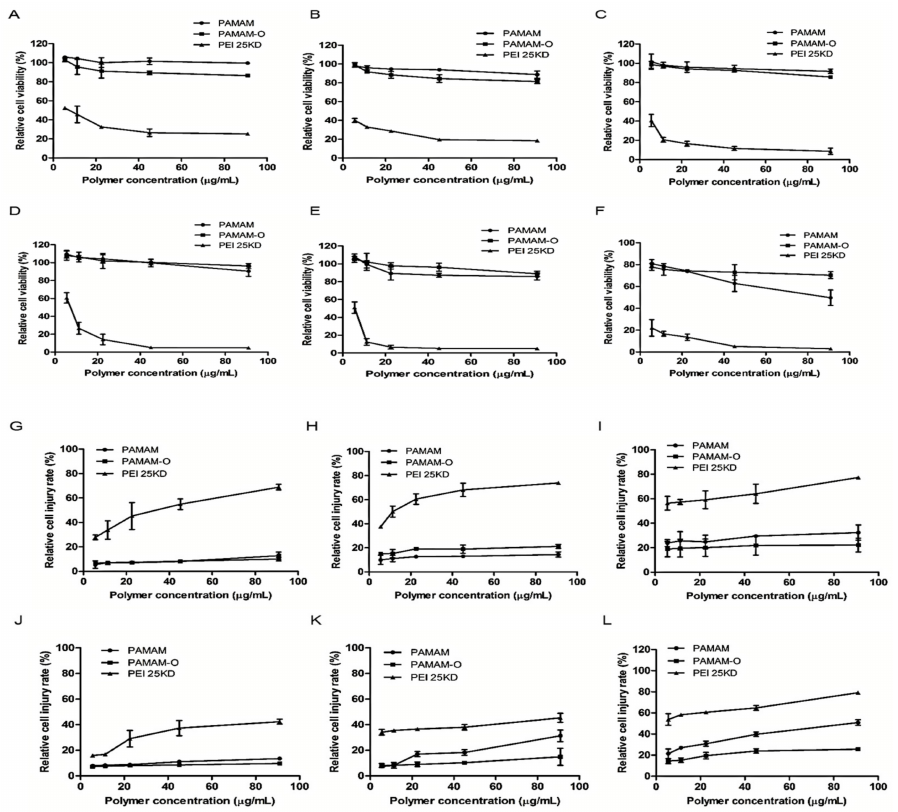
Figure 3. Cell viability assay for the PAMAM and PAMAM-O dendrimers. HepG2 cells were treated with different doses of PAMAM and PAMAM-O dendrimers. After 24 h ( A ); 48 h ( B ); and 72 h ( C ), cell viability was measured by the EZ-Cyto Reagent. Dermal fibroblasts were treated as in panels A, B, and C. After 24 h ( D ); 48 h ( E ); and 72 h ( F ), cell viability was measured by the WST assay. Data represent the mean ± standard deviation ( n = 3) of three independent experiments. HepG2 cells were treated as in panels A, B, and C. At 24 h ( G ); 48 h ( H ); and 72 h ( I ) after incubation, cell viability was analyzed using lactate dehydrogenase (LDH) assays. Dermal fibroblasts were treated as in panels D, E, and F. At 24 h ( J ); 48 h ( K ); and 72 h ( L ) after incubation, cell viability was analyzed using LDH assays. Data represent the mean ± standard deviation ( n = 3) of three independent